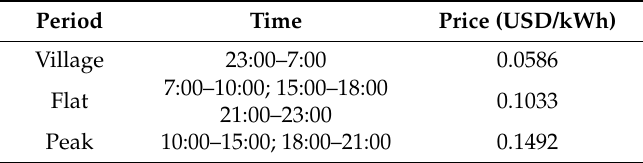
Table 3. Time-of-use (TOU) electricity